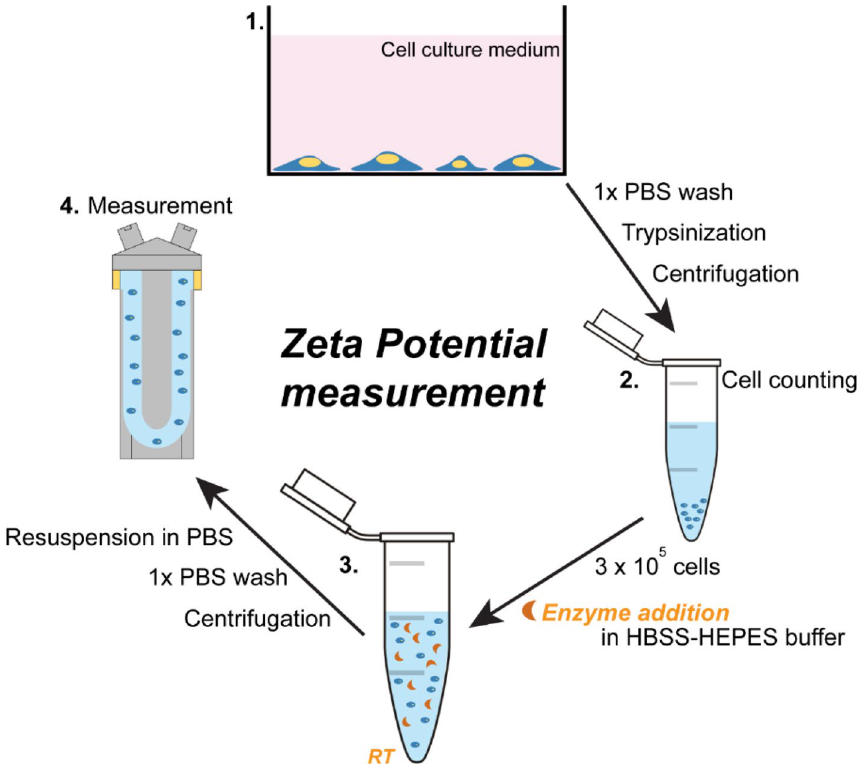
Figure 1. Zeta potential measurement on cells. Cartoon explaining point-by-point the steps of the zeta potential measurement performed on cell suspensions. Adherent cells were collected with trypsin, counted, and treated with ChrABC enzyme in HEPES HBSS buffer. At the end of the incubation time cells were centrifuged, the cell pellet washed with PBS and zeta potential of cells was measured using a Malvern Zetasizer Nano